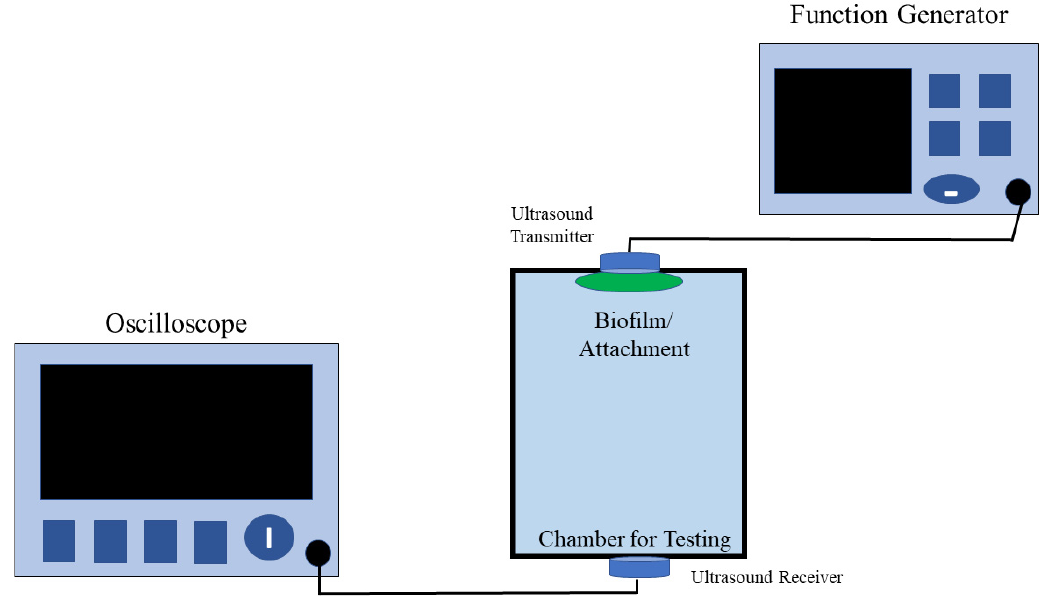
Figure 2. Schematic representation of the sensor arrangement. In the image, two sensors—a transmitter sensor and a receiver sensor—are placed on either side of the chamber.